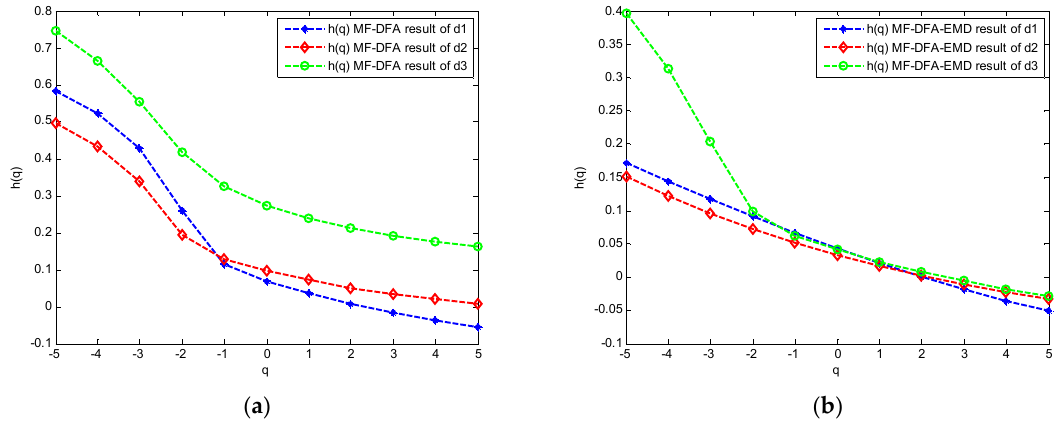
Figure 7. 𝑞 − ℎ(𝑞) curves of three signal components obtained using: ( a ) the traditional MFDFA algorithm; and ( b ) the new MFDFA algorithm.